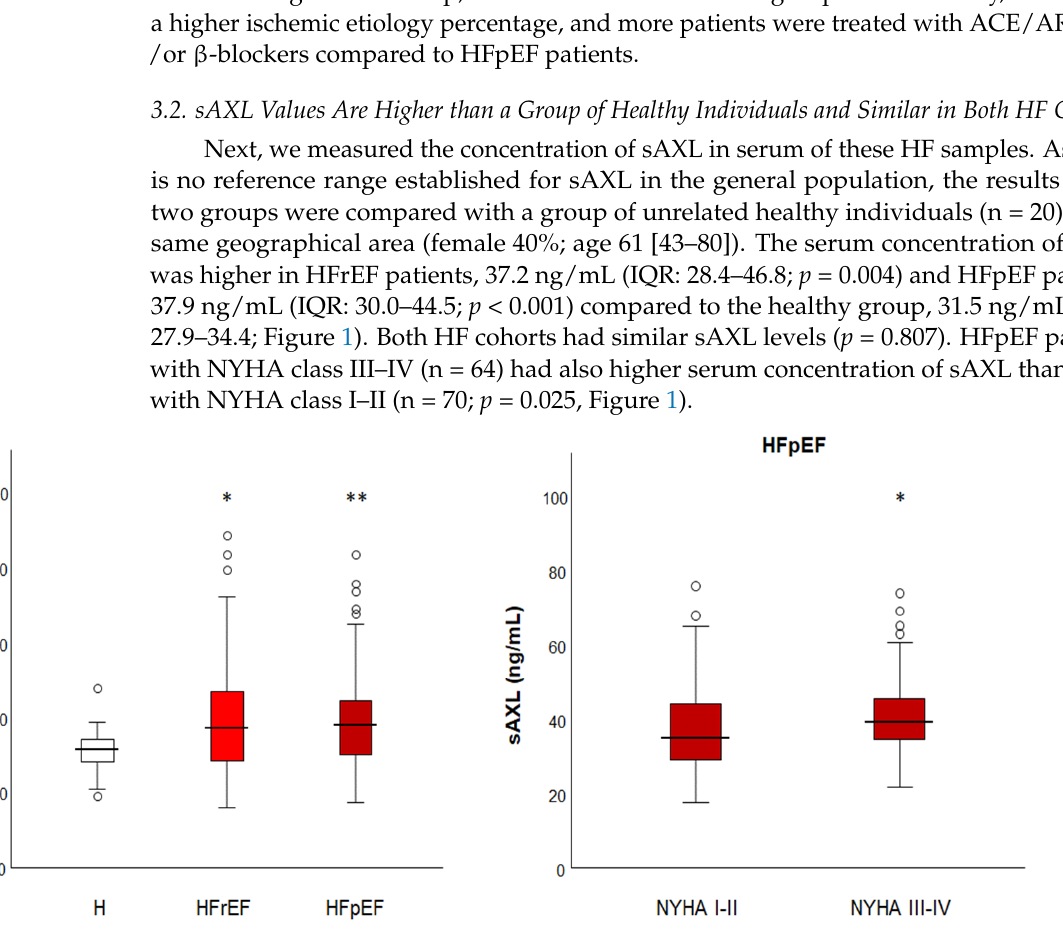
Figure 1. Box-plot representation of soluble AXL levels in serum by groups: healthy (H, white), HF with reduced ejection fraction (HFrEF, light red) and preserved ejection fraction (HFpEF, dark red) patients (left). Dots represent outliers. ANOVA analysis among groups was significant ( p = 0.029). Post hoc analysis showed significant differences of HF groups vs. healthy individuals. Right, soluble AXL levels in HFpEF patients with lower NYHA class (I-II) compared to higher NYHA class (III-IV). Significance is denoted by * p < 0.05; ** p < 0.01.